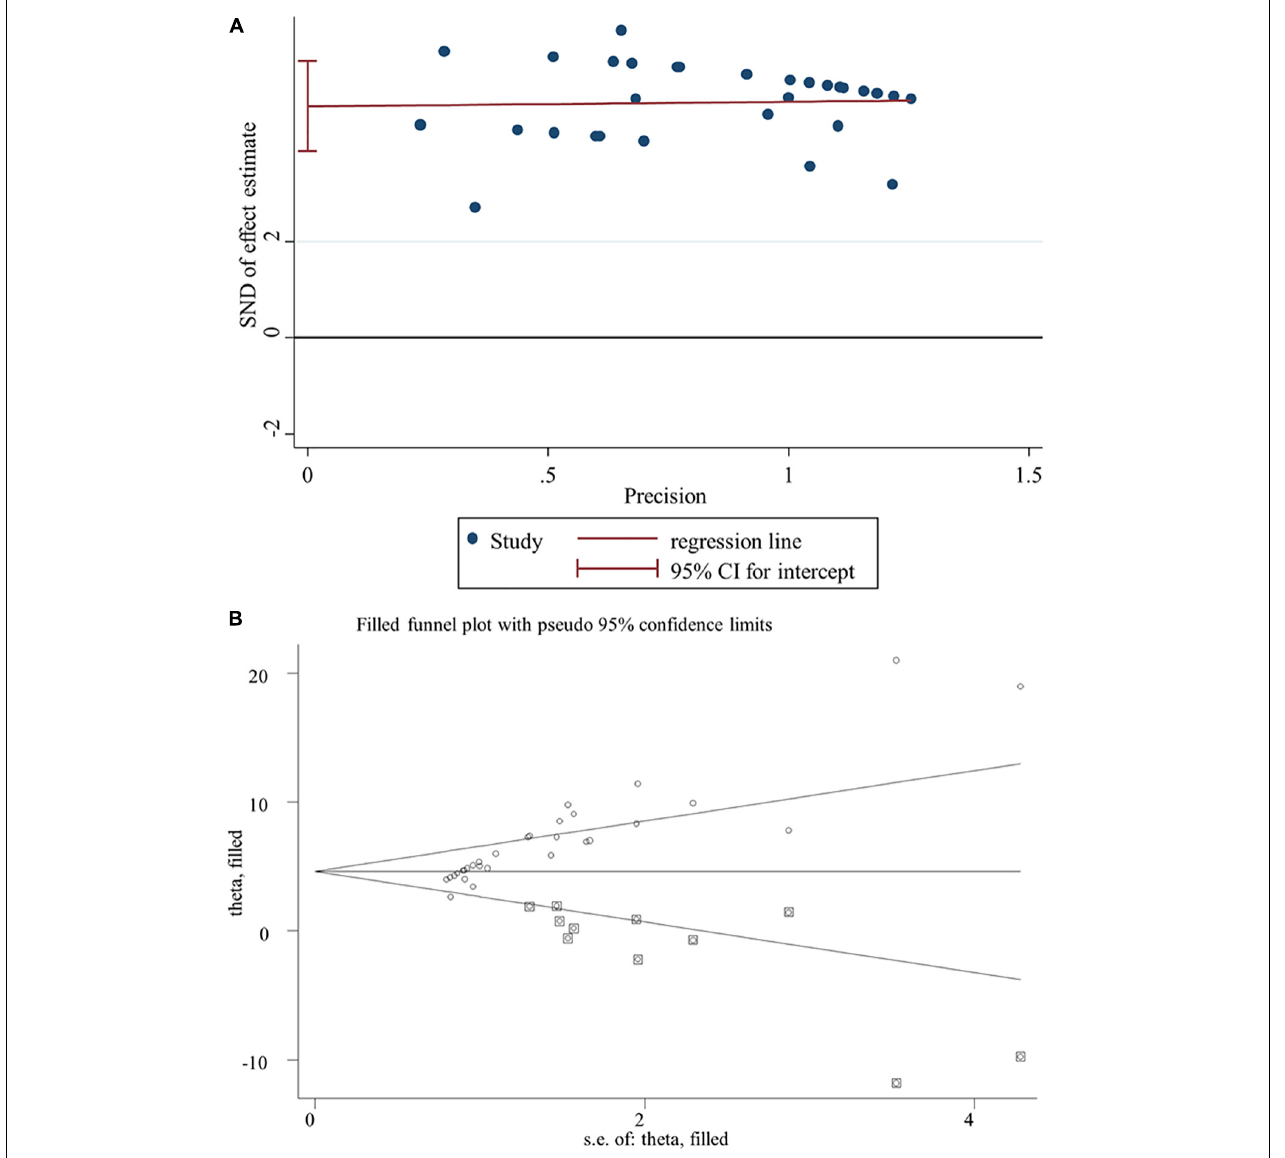
FIGURE 8 | Publication bias analysis for SOD. (A) Egger’s publication bias plot; (B) the trim-and-fill analysis to adjust estimates. SND, standard normal deviation; CI, confidence